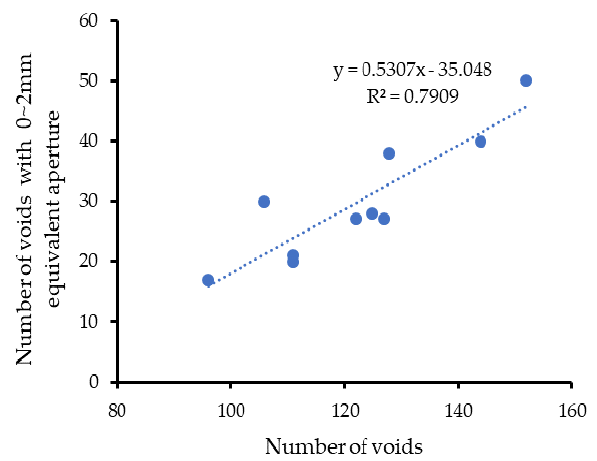
Table 1. Coefficient Determinant Matrix.